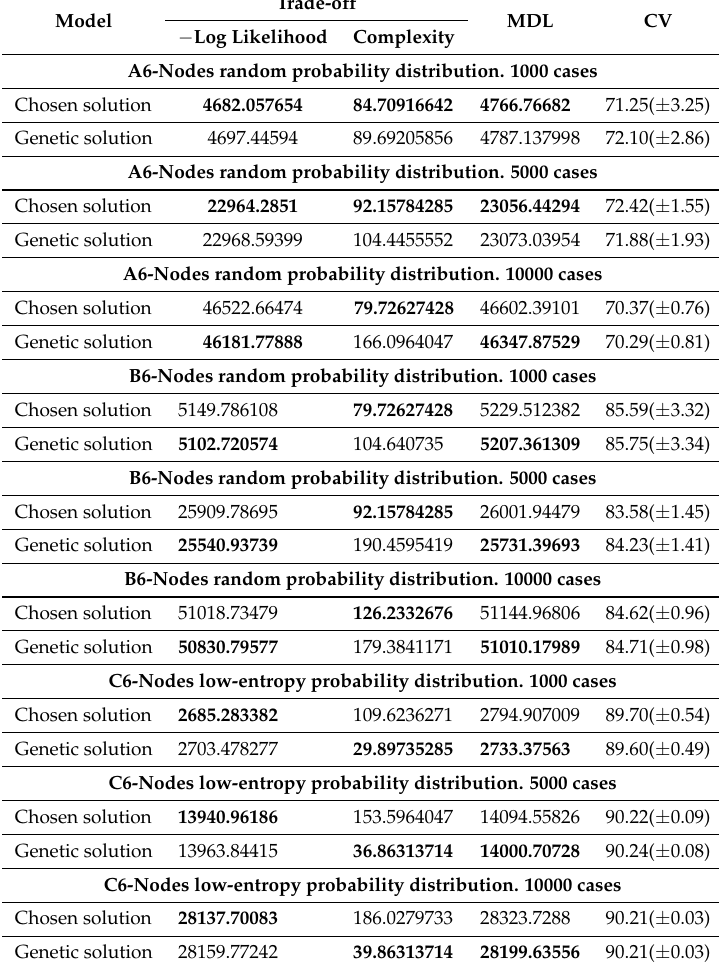
Table 2. Comparison between the NS2BN and the GABN solutions. Values in parentheses represent the standard deviation, for the case of -Log-Likelihood, complexity, and MDL the minimum value is in boldface . For the case of the CV, we carry out the t-test and values in boldface mean the significant best value